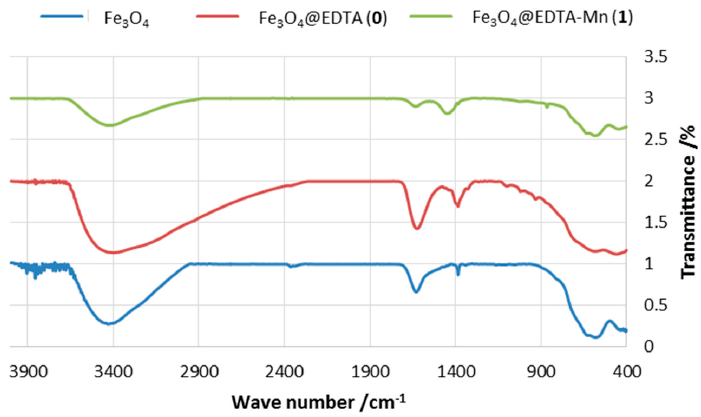
Figure 1. FT ‐ IR (Fourier Transform Infrared) spectra of Fe 3 O 4 , Fe 3 O 4 @EDTA ( 0 ) and Fe 3 O 4 @EDTA ‐ Mn 2+ ( 1 ) MNPs in the range of 4000 and 400 cm − 1 .